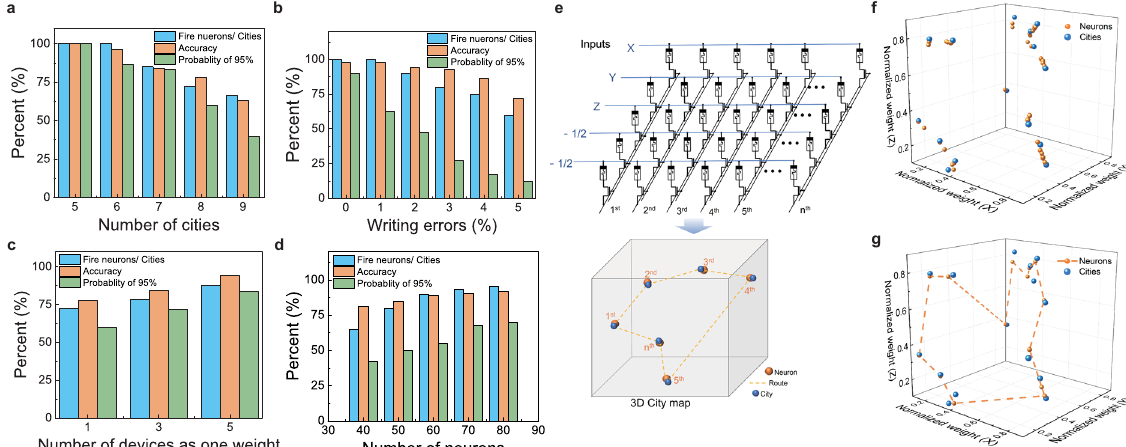
Fig. 4 Optimization of memristor-based SOM for TSP. a Result of the different number of cities (from 5 cities to 9 cities) TSPs with memristor-based SOM of 20 neurons. The number of cities increase, the complexity of the problem increases, and the accuracy would decrease. The SOM can perfectly solve the 5-city TSP. With the increase of the number of tested cities, the number of cities that cannot be distinguished increases. And the accuracy and the P 95% decreases to 68% and 36% simultaneously. b The impacts of the writing errors, a 20-city TSP with a 4 × 70 array, are simulated. The acceptable shortest route can be achieved with 0% writing error. With the increasing of wring error, the ratio between the fi ring neurons and the cities is decreased. And the accuracy and P 95% decrease to 75% and 13%with a 5% writing error. c Experimental result of using multiple (3 and 5) devices to represent one weight in 20 neurons SOM for 8-city TSP problems. Using more devices can decrease writing errors and increase accuracy and probability. d A 20-city TSP was solved in simulation to show the effectiveness of increasing the number of output nodes. With the increasing number of nodes, the ratio between fi ring nodes and cities is signi fi cantly increasing, whereas the accuracy and probability are simultaneously increased. e – g To show the potential of solving the complex problem of our system, a 15-city 3D-TSP is tested with 5 × 45 array. e The city map in 3D space, and the weight map of all neurons after training in city map. f Testing result of 15-city 3D-TSP. The blue dots represent the position of the cities. Orange dashed line is the shortest route in 3D space determined by sorting the winners when applying different cities into the